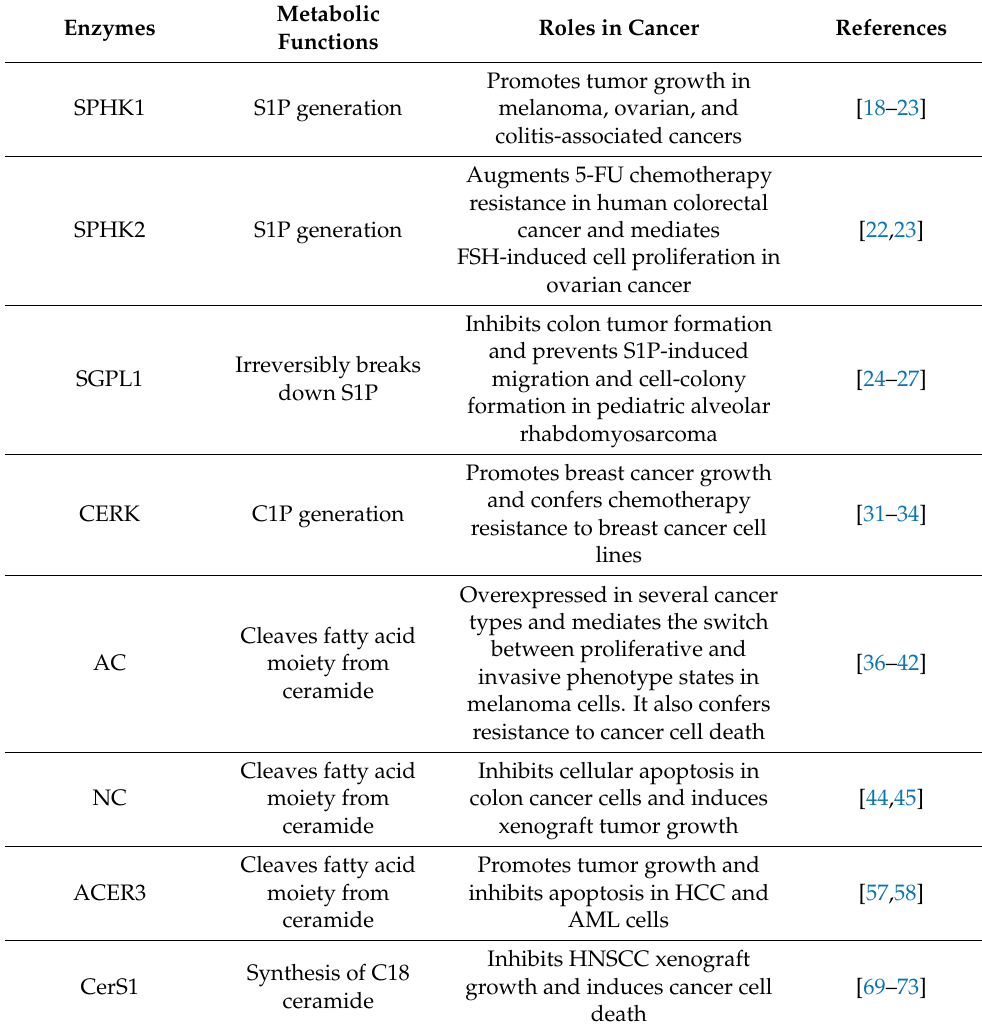
Table 1. Key Sphingolipid enzymes and their roles in cancer